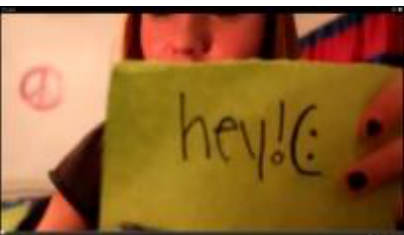
Figure 1. Opening. Source: http://www.youtube.com/wat ch?v=4GIENGcZnS4.